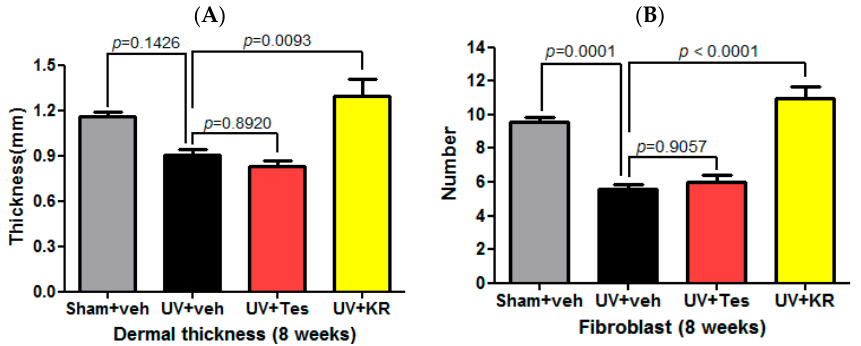
Figure 3. Effects of a mixture of extracts of Kochia scoparia and Rosa multiflora (KR) on the dermis in photoaging murine skin. Dermal effects were assessed by measuring dermal thickness ( A ) and counting the number of fibroblasts ( B ) in photoaging skin treated with topical KR, vehicle (veh), or tesaglitazar (Tes) for 8 weeks. Dermal thickness was defined as the distance from the subcutaneous fat to the dermal–epidermal junction. UV radiation decreased fibroblasts and dermal